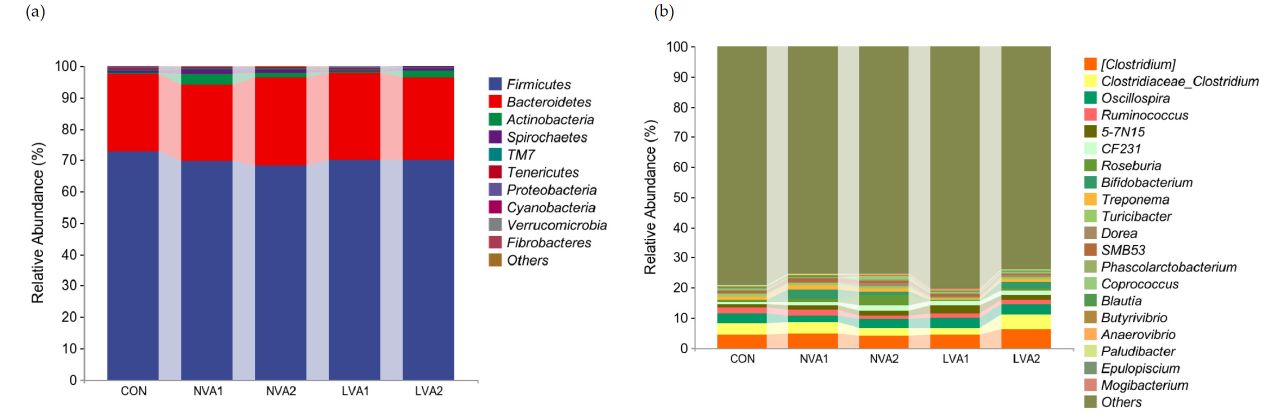
Figure 5. Effect of ATRA on the composition of intestinal microflora. The relative abundance of intestinal flora is shown in the stacked bar chart, including the change in taxa with significant differences at the phylum ( a ) and genus ( b ) levels.